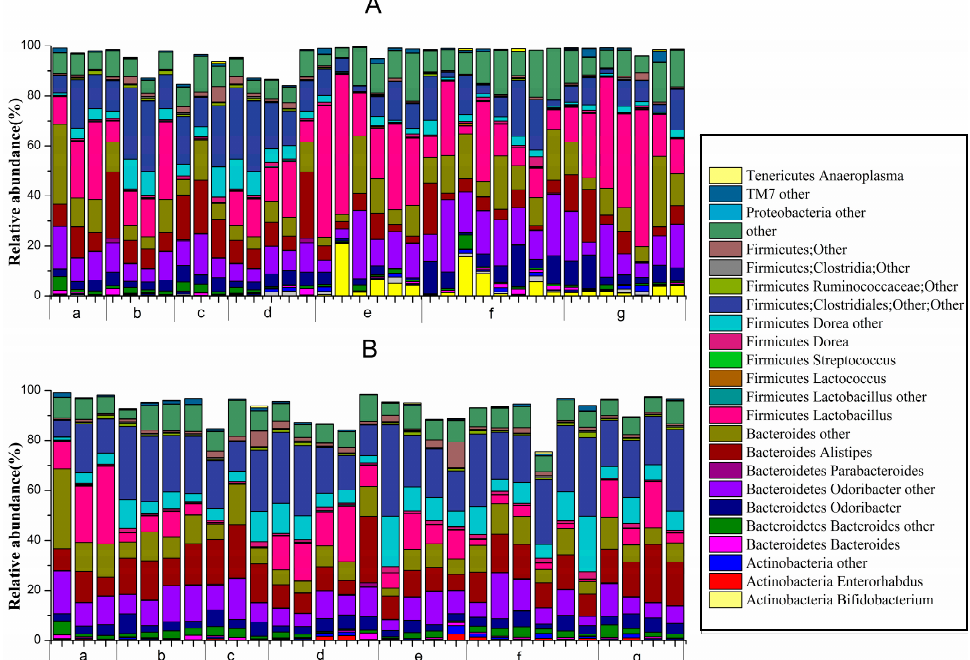
Figure 7. Relative abundance of main genera >0.1% at d1422-0067/18/02/0317/s2ifferent periods